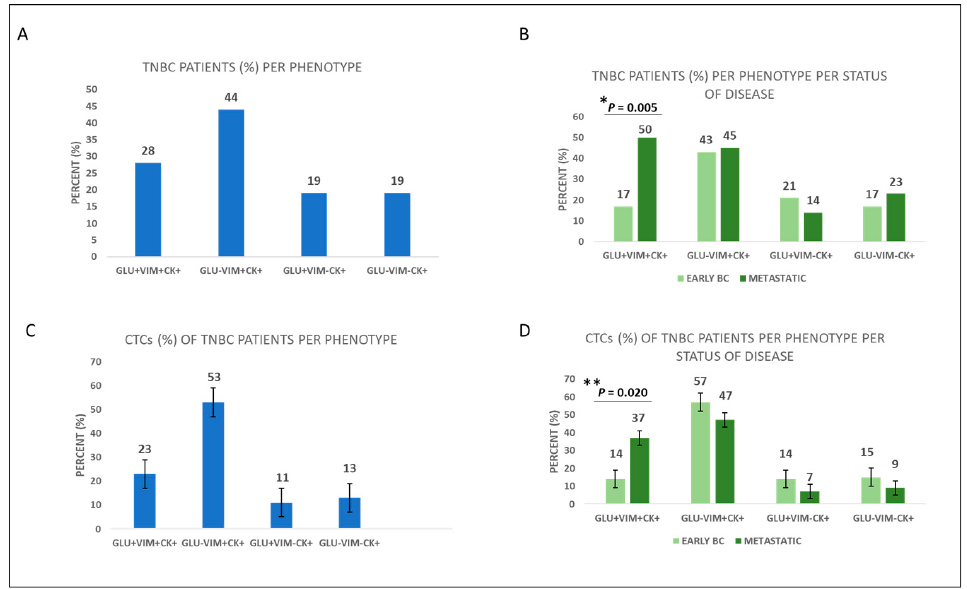
Figure 5. GLU and VIM expression in TNBC patients’ CTCs. ( A ) Percentage of TNBC patients with all the different phenotypes. ( B ) Percentage of early and metastatic TNBC patients with the corresponding CTC phenotypes (* p = 0.005). ( C ) Percentage of CTCs with all the corresponding phenotypes in TNBC patients. ( D ) Percentage of CTCs with all the corresponding phenotypes in early and metastatic TNBC patients (** p = 0.020).